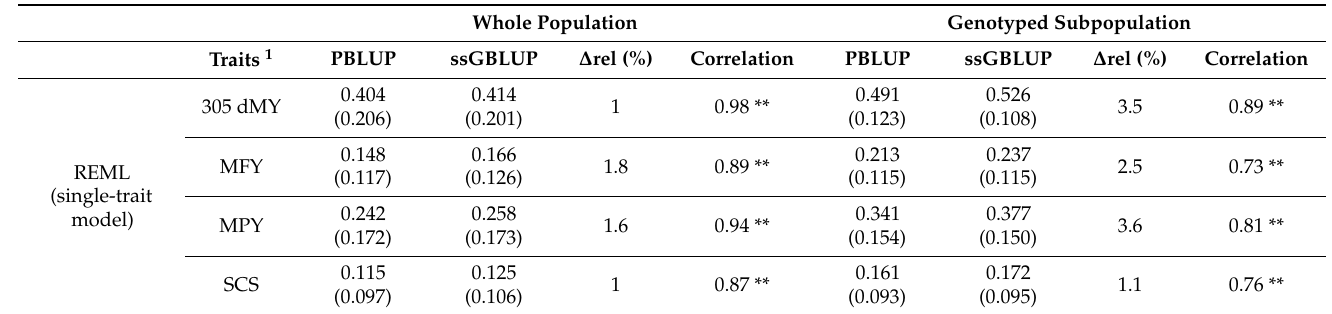
Table 3. Comparison of estimated breeding value (EBV) and genomic estimated breeding value (GEBV) reliability, Spearman’s rho (PBLUP and ssGBLUP) and increases in reliability ( ∆ rel) ob- tained for the whole population and the genotyped subpopulation by different methods in Xinjiang Brown